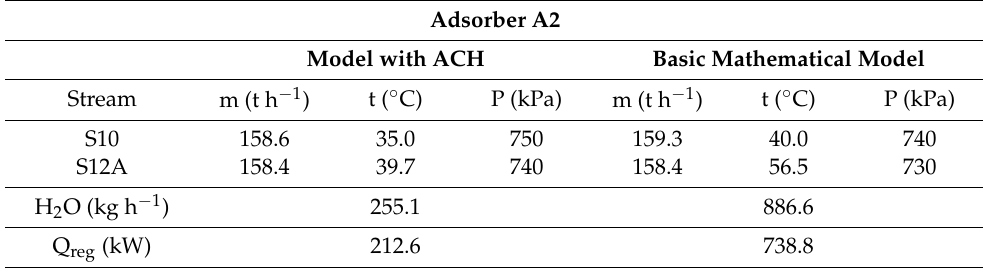
Table 10. Comparison of key parameters related to adsorber A2 obtained by basic ASU model and by model comprising